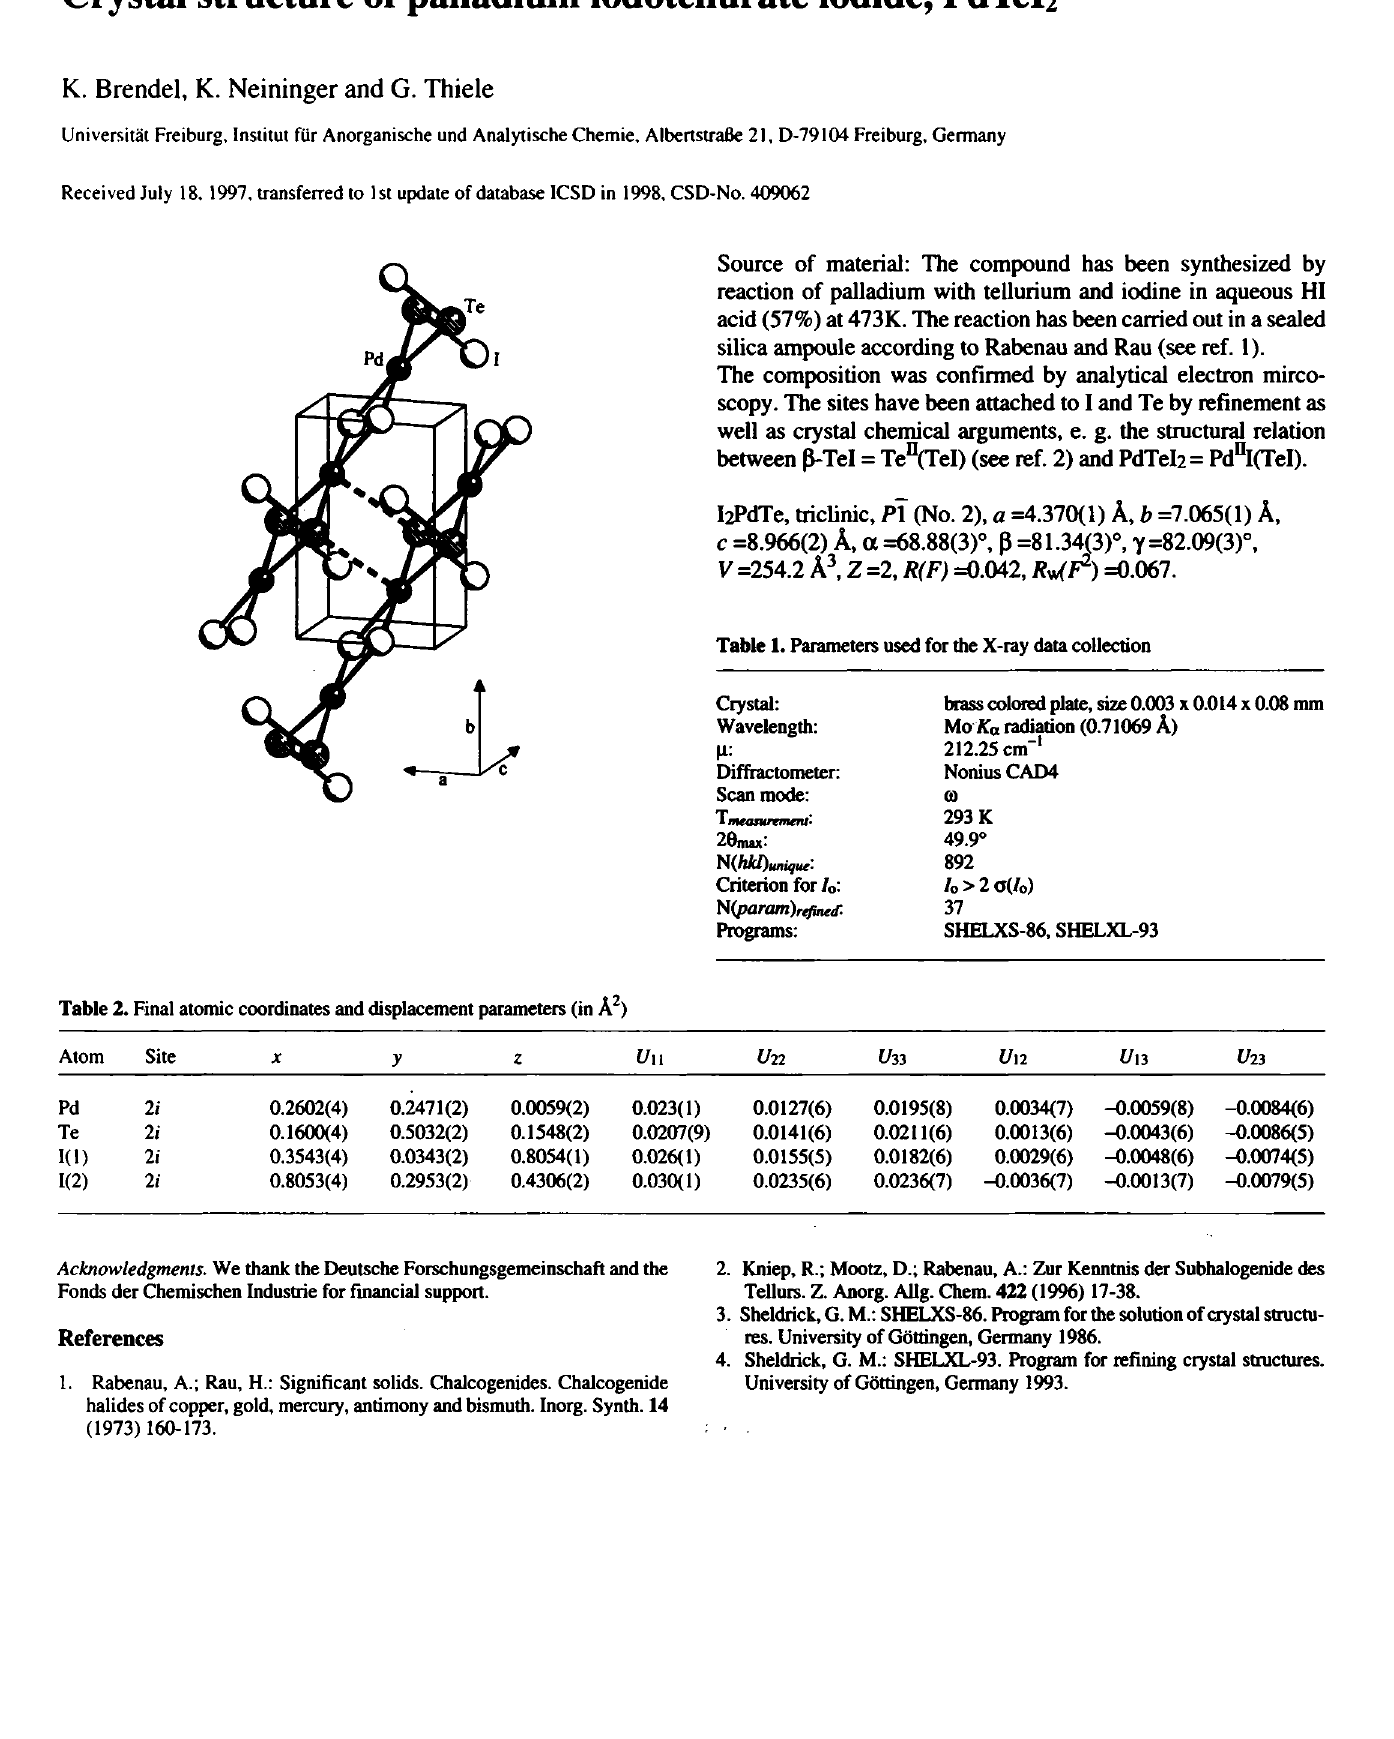
Table 2. Final atomic coordinates and displacement parameters (in Л^) Atom